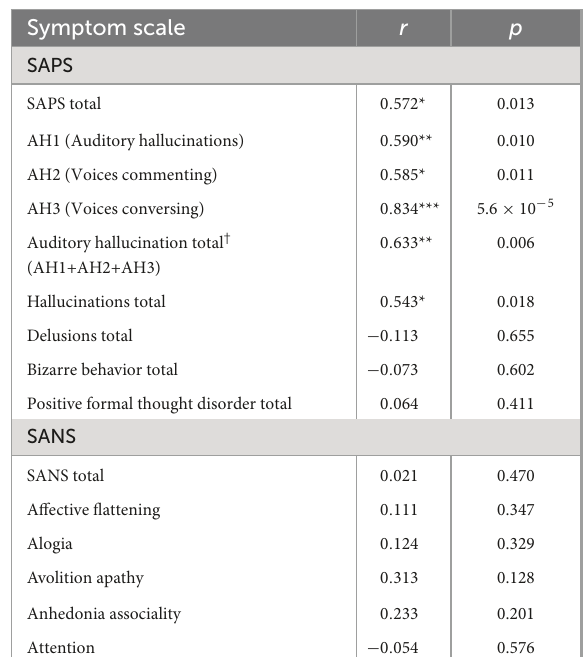
TABLE 1 Symptom specificity of predictions from the network targeting accuracy (NTA)